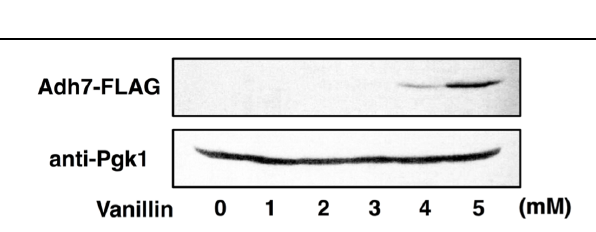
FIGURE 7 | Expression of the ADH7 gene in the presence of low concentrations of vanillin. Levels of Adh7 protein expression were determined by western blot analysis using an anti-FLAG antibody. Cells carrying a FLAG-tagged chromosomal copy of the ADH7 gene were treated with vanillin. Pgk1 was used as a loading control. Cells were treated with the indicated concentrations of vanillin for 60